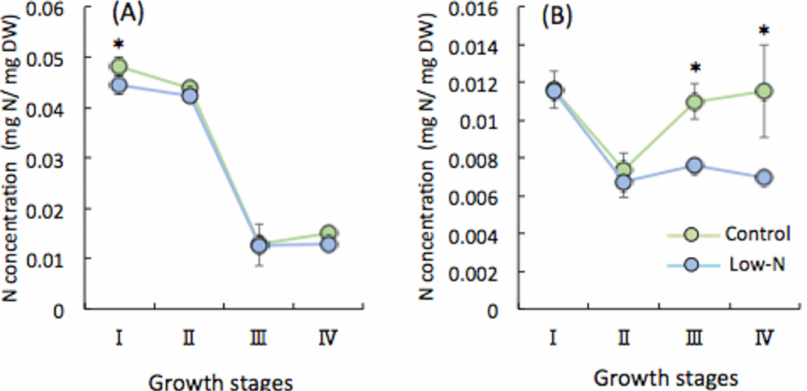
Figure 2. N contents in ( A ) leaves and ( B ) roots. I, II, III, IV refer to before and after topdressing at tiller initiation and early panicle formation stages. Each point represents the mean value, error bars indicate mean ± SD of 5 replicates. * Significant di ff erence ( p < 0.05, Student’s t